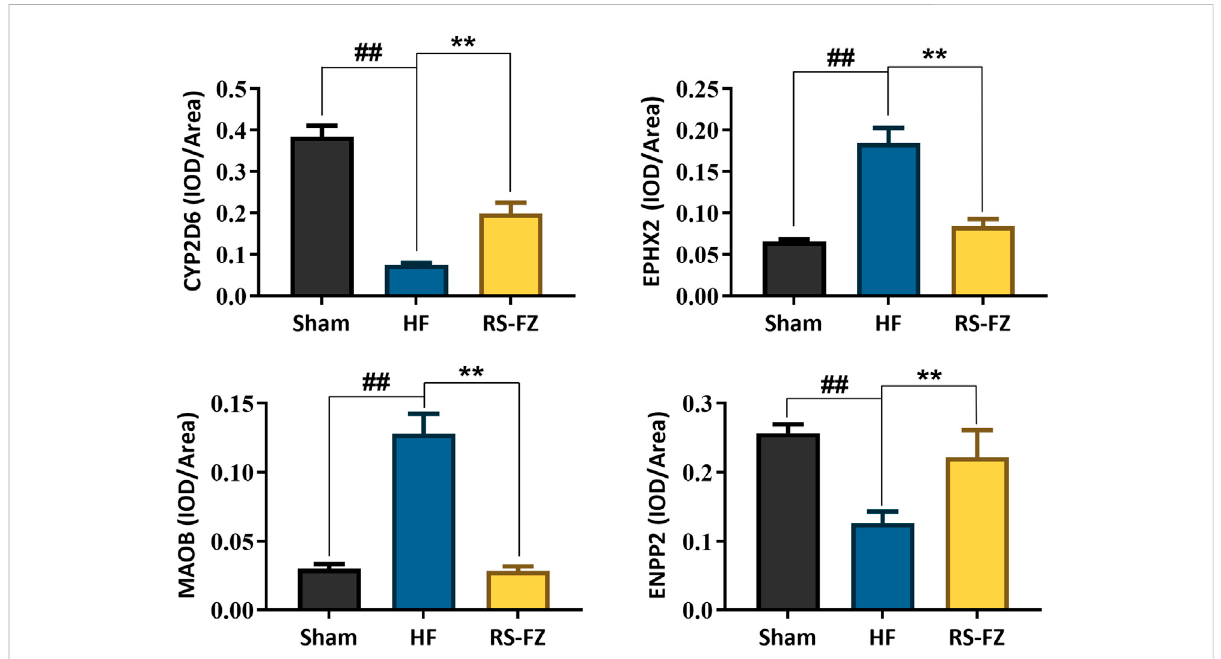
FIGURE 8 The effect of RS-FZ on the expression of CYP2D6, EPHX2, MAOB, and ENPP2 in the treatment of HF detected by immunohistochemistry staining (×400). The data are expressed as the mean ± SD, n = 3. Compared to Sham group, ## p < 0.01; Compared to HF model group, * p < 0.05, ** p <